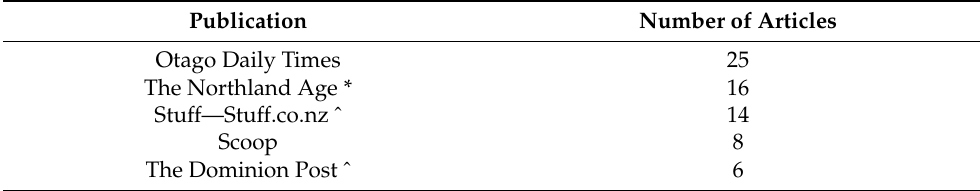
Table 1. Publications and number of